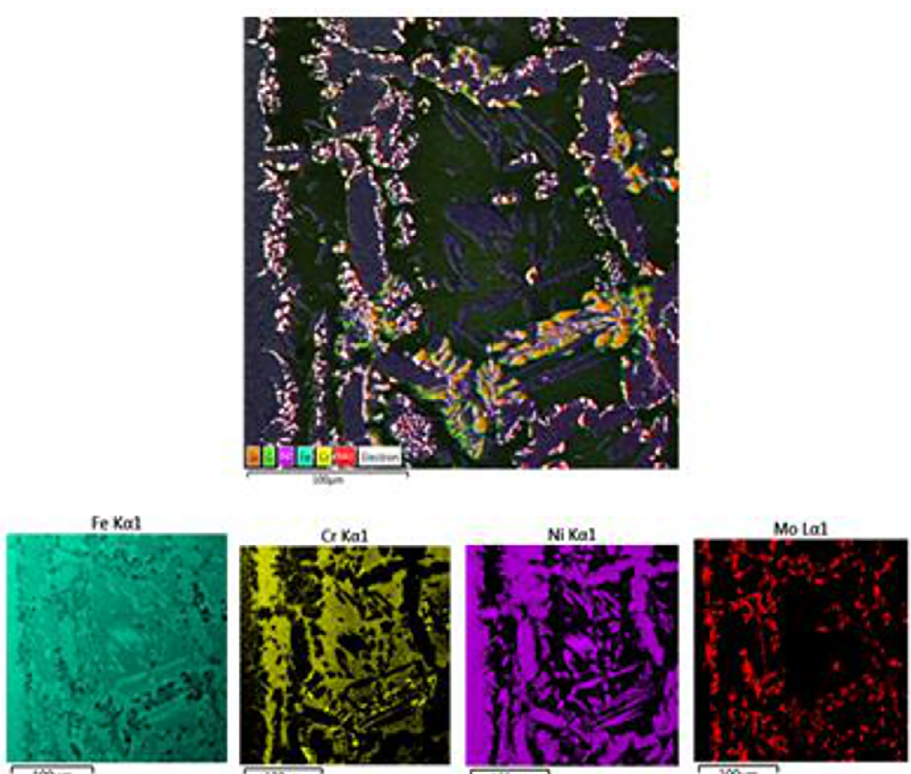
Figure 5. EDS compositional mapping for sample aged at 830C for 180